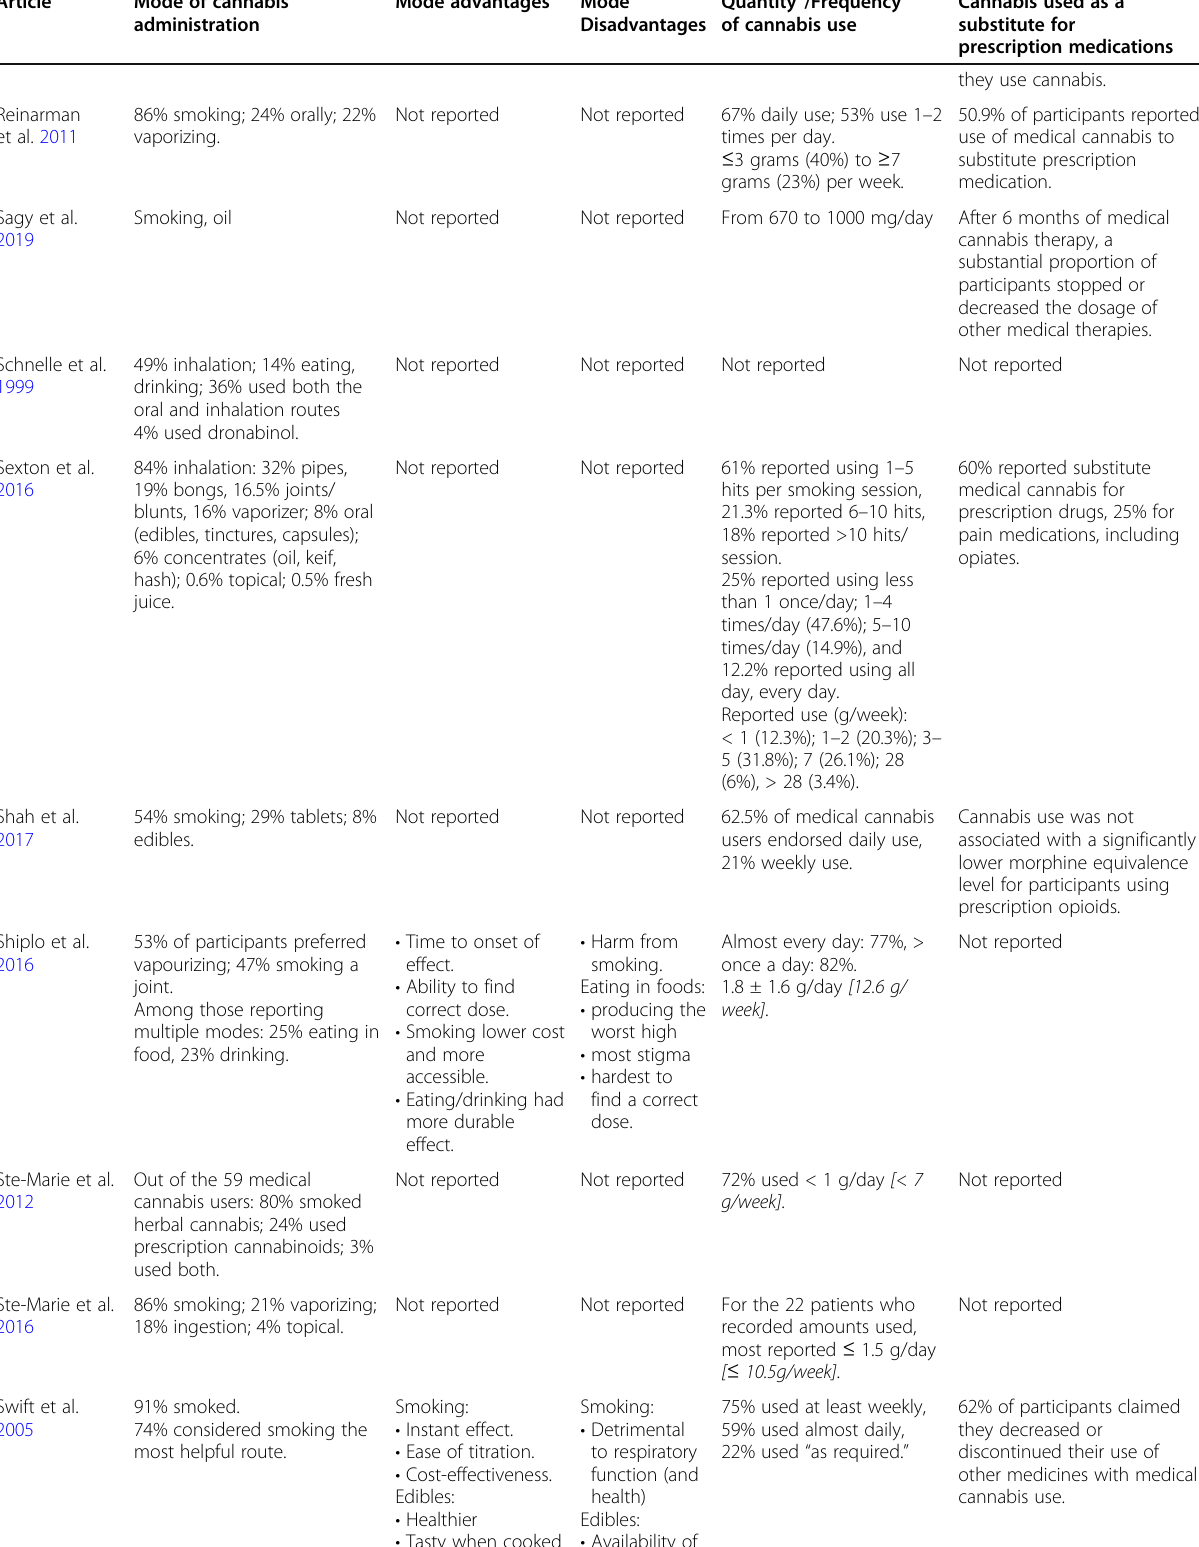
Table 2 Patterns of medical cannabis use and utilization of medical cannabis as a substitute for prescription medications